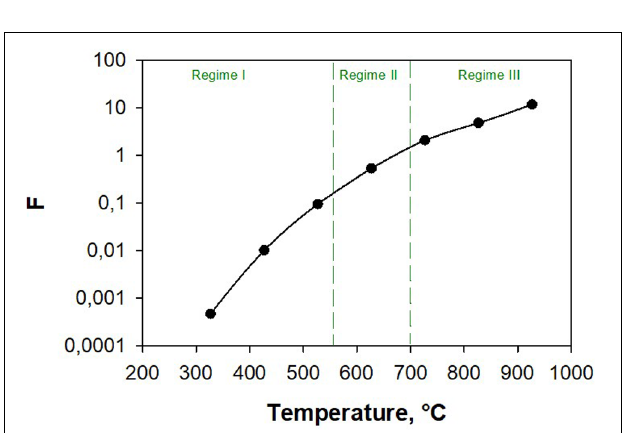
FIGURE 6 | Ratio between CO and H 2 production as a function of temperature during isothermal co-splitting simulations.